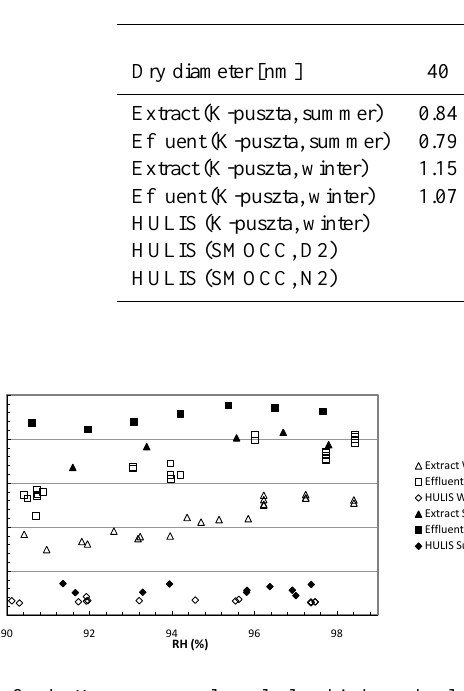
Fig. 4. κ R for the K-puszta samples calculated independently from GFs at all RHs.